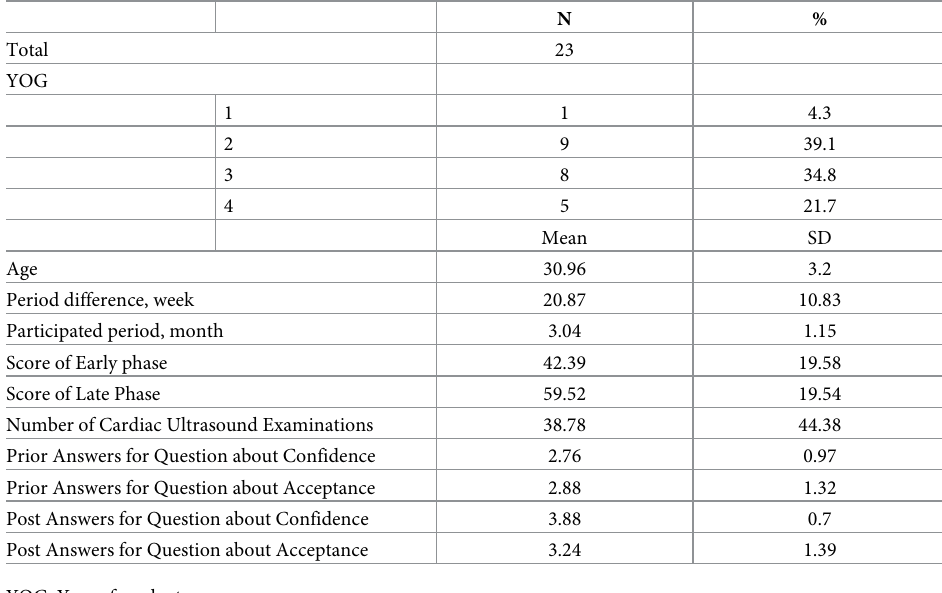
Table 3. Characteristics of study population and bedside cardiac